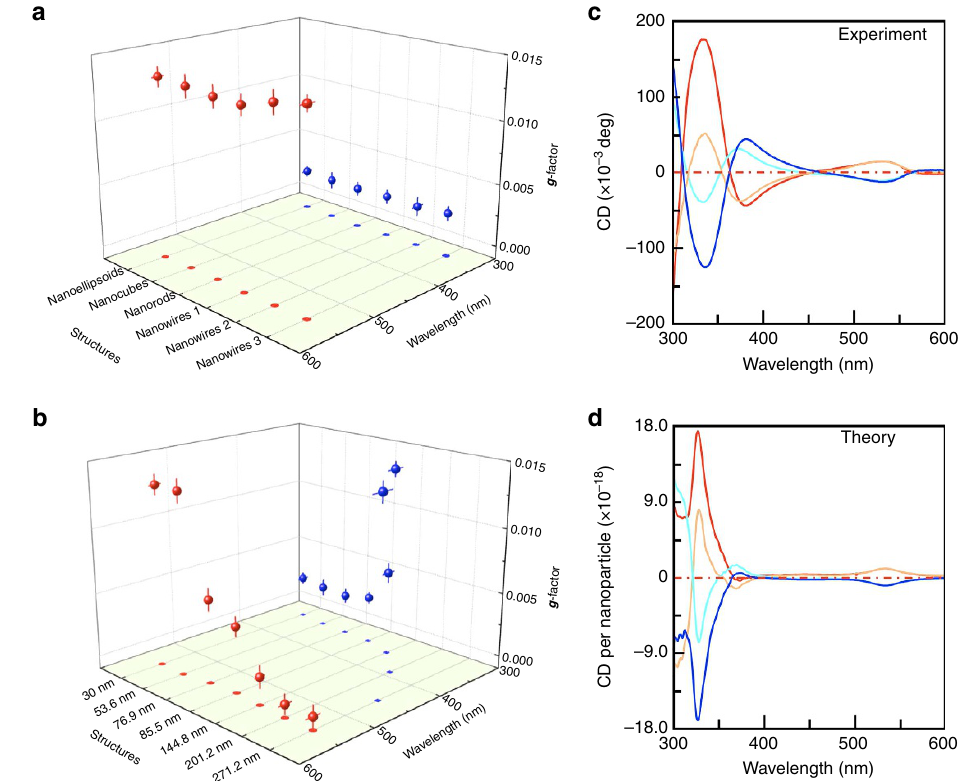
Figure 4 | Chiroptical response of a -HgS nanostructures with interplay between crystallographic and geometric handedness. ( a ) Summary of g factors of a -HgS nanoparticles, possessing chiral ( þ ) C -lattice but different achiral morphology. ( b ) Wavelength dependent evolution of g -factor peaks with size for the ( þ ) C -M twisted triangular bipyramid a -HgS nanoparticles. In ( a , b ) projections of the g factors onto the basal plane are also presented to highlight wavelength shifting of peak position. ( c ) Comparison of CD spectra of 85nm long twisted bipyramid a -HgS nanoparticles with different combination of crystallographic and geometric handedness. Red, ( þ ) C -M. Orange, ( þ ) C -P. Cyan, ( (cid:2) ) C -M. Blue, ( (cid:2) ) C -P. ( d ) Computed CD spectra to compare with c . Colour codes are assigned to be the same as those in c . The experimental dissymmetric g -factor and its associated error bar are determined as average and standard deviation of statistical analysis over different sample batches and different runs of measurement,